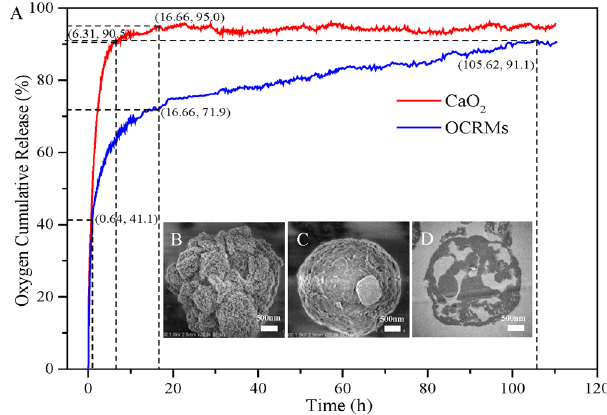
Figure 3. ( A ) Shows the oxygen cumulative release profiles obtained by dispersing CaO 2 and oxygen controlled-release microspheres (OCRMs) in anaerobic water in a closed system at 25 °C; ( B ), ( C ) and ( D ) are FESEM images and a TEM image of an ultrathin section obtained from the product of the OCRMs reacting with water at 0, 0.64 and 16.66 h, respectively. The numbers in the brackets are data points (hour, percentage) at key reaction